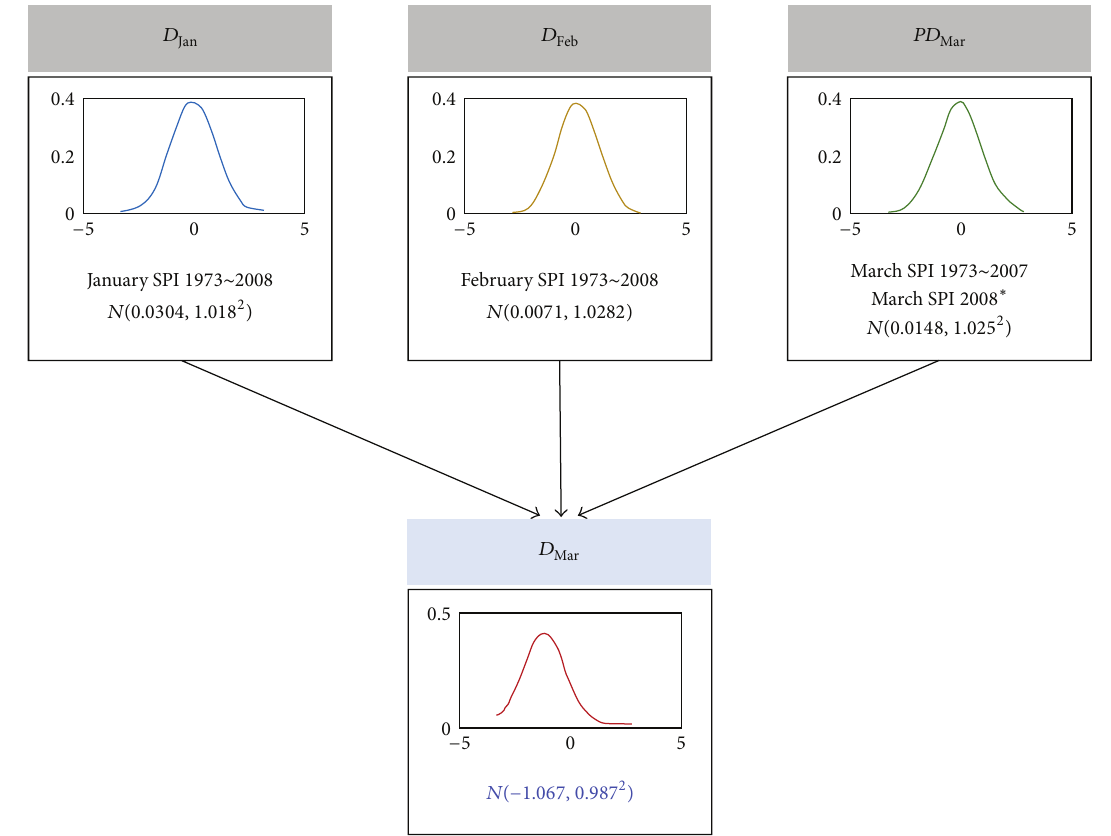
Figure 4: An example of the Bayesian network-based drought forecasting model for Wonju station ( ∗ one-month lead predicted precipitation of APCC MME was applied to calculate March